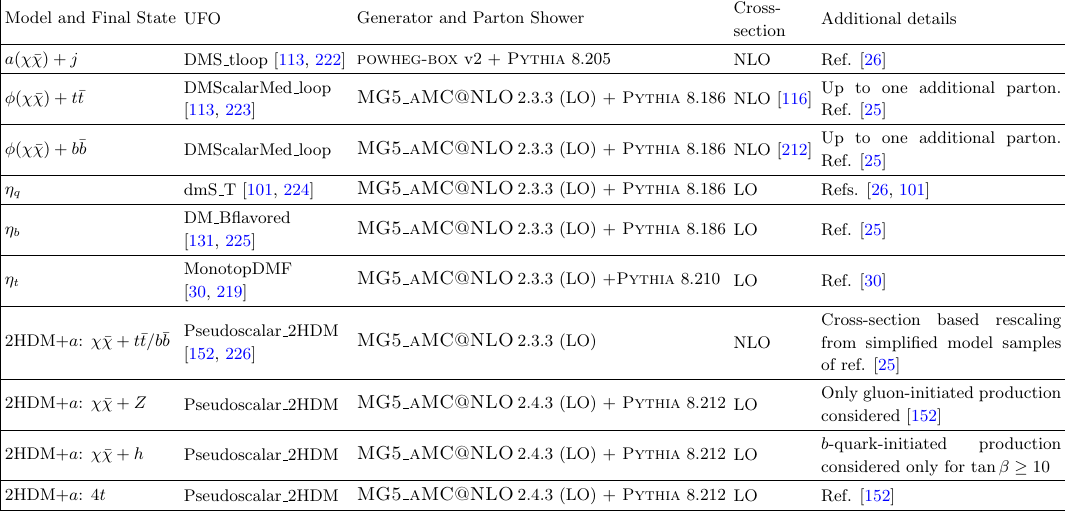
Cross-section based rescaling NLO from simpli(cid:12)ed model samples of ref. [25]